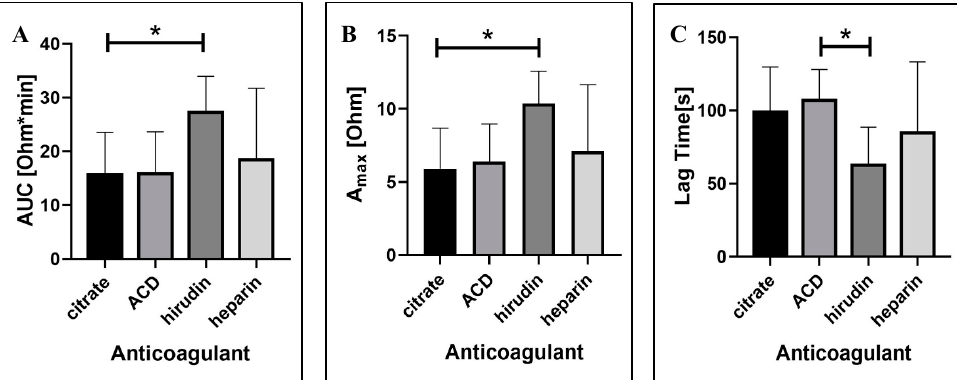
Figure 3. The effect of anticoagulant regimen on ADP-induced platelet aggregation in ACD-anticoagulated whole blood: ( A ) area under the curve (AUC); ( B ) maximum aggregation (Amax); ( C ) lag time. Data from 4 independent experiments using blood samples from 4 di ff erent individuals are reported. Mean ± SD as error bars of aggregation parameters are indicated, ANOVA: no asterisk— p > 0.05; * p <